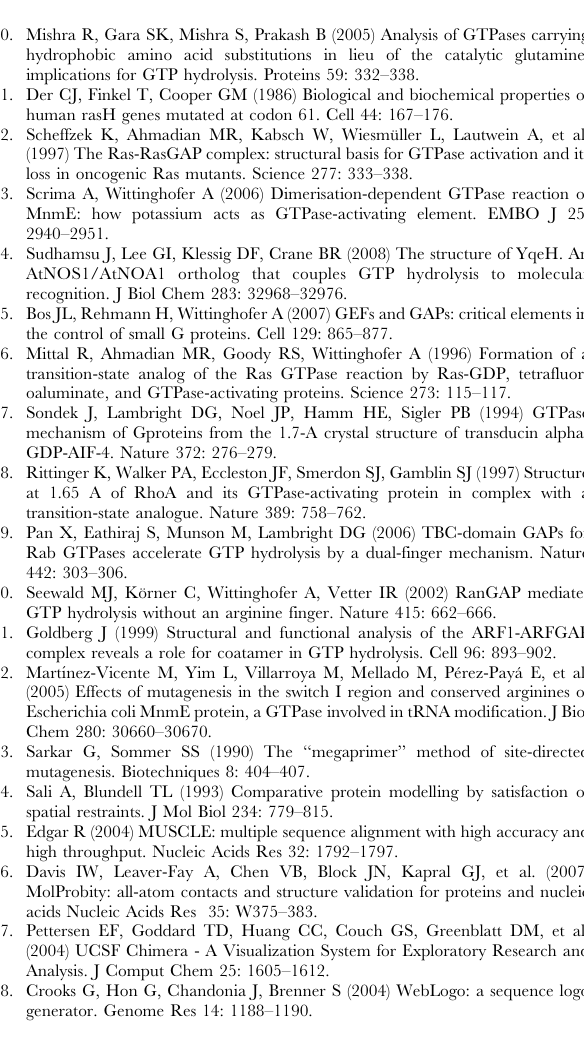
Table S1 List of primers used in generating YqeH